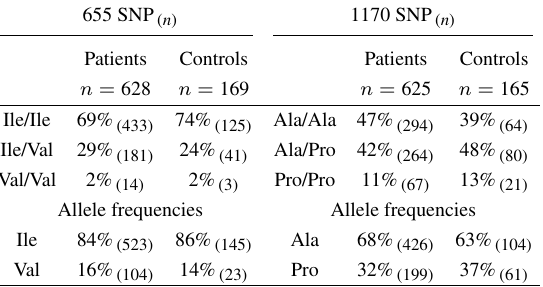
Hardy–Weinberg equilibrium: p = 0 . 8 and p = 0 . 1 for 655SNP in healthy controls and patients and p = 0 . 6 and p = 0 . 3 for 1170SNP in healthy controls and